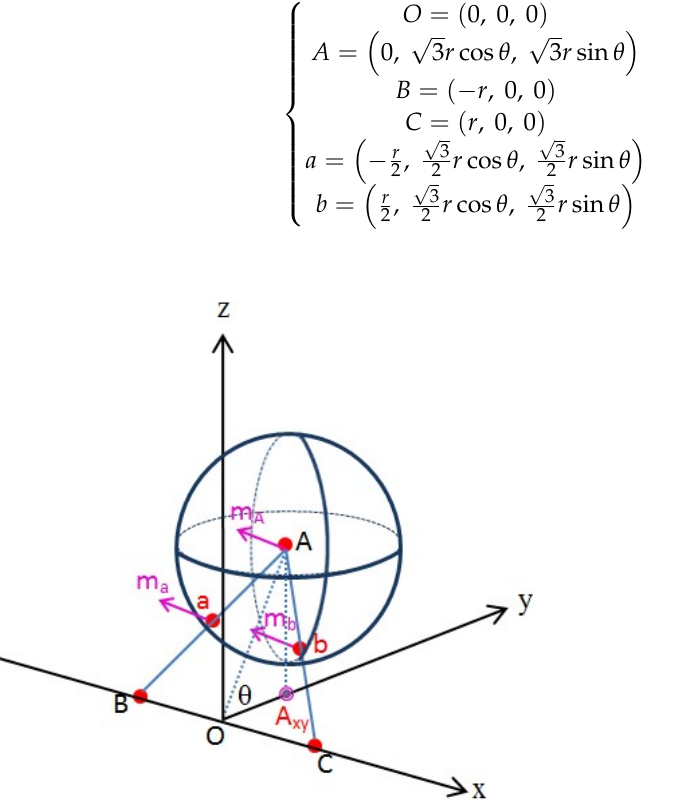
Figure 4. Motion of Ball A in the upper shear box against Balls B and C. m A , m a and m b are movement vectors at Point A (Ball A center), and contact points a and b.